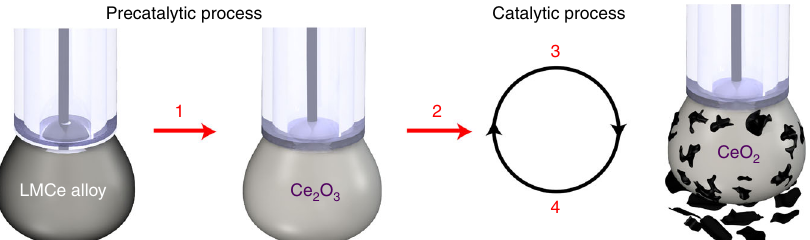
Fig. 3 Schematic of the catalytic process. The proposed process is based on operando Raman measurements, it includes pre-catalytic reactions and the catalytic cycle for the CO 2 reduction to amorphous carbon sheets. The picture is created by authors